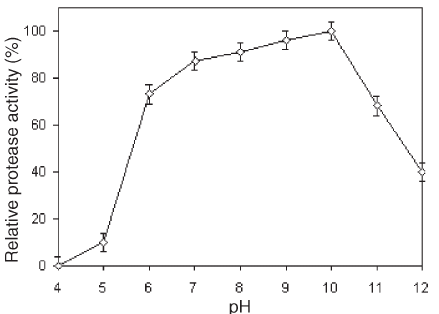
Figure 2. Activity of purified protease from Halogeometricum borin- quense strain TSS101 at different pH values. Azocaseinolytic activity was measured at 60 °C in the presence of 20% NaCl in the indicated buffers at a concentration of 0.1 M. Each value represents the mean ± SE of three independent